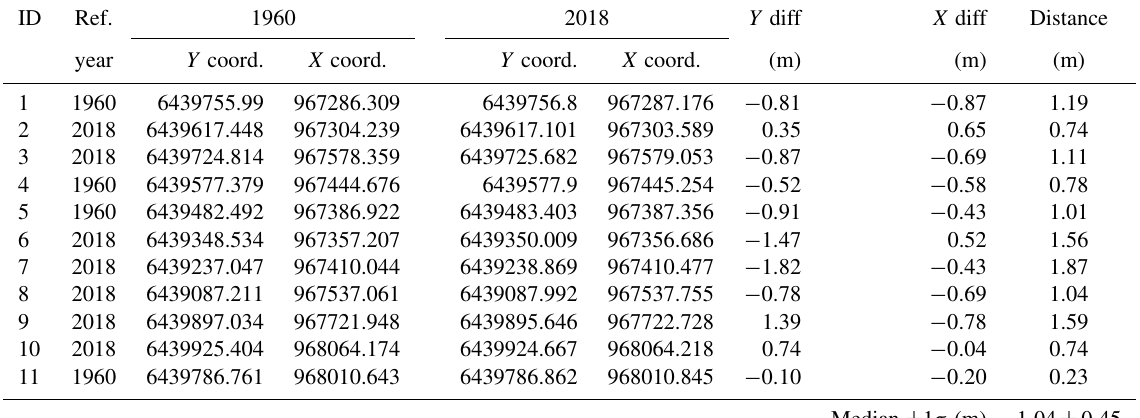
Table A2. Results of the manual control point assessment between the orthomosaics of 1960 and 2018. Locations of the points are shown in Figs. 3 and A1. Coordinates are mentioned in the EPSG:2154 – RGF93 v1/Lambert-93 systems. ID